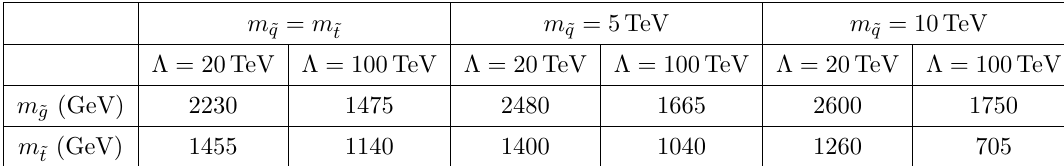
requiring (cid:1) = 10 for t